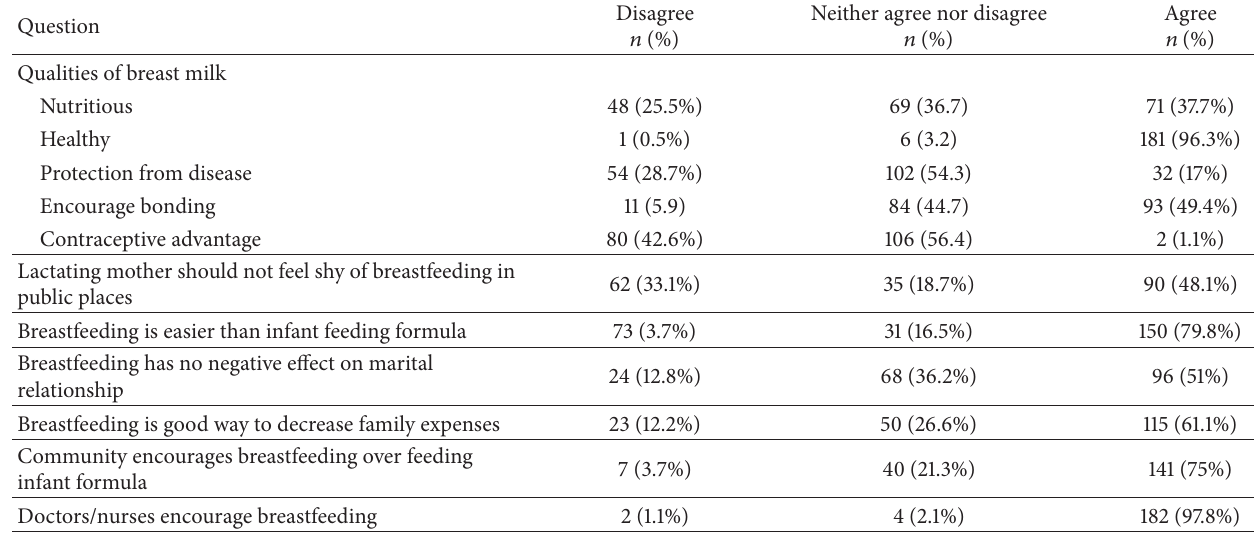
Table 3: Perceptions on the various aspects of breastfeeding ( 𝑛 = 188 ).